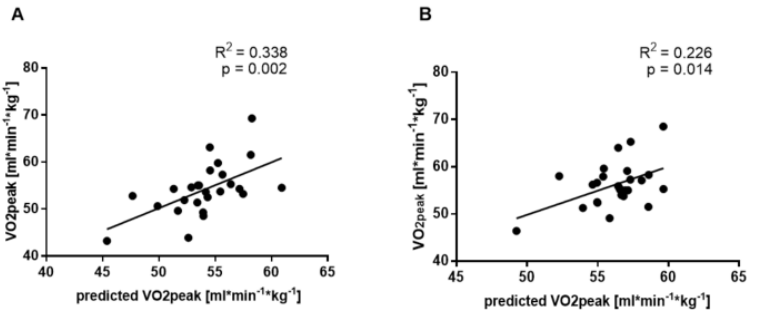
Figure 2. The linear relationship between VO 2peak and predicted VO 2peak before ( A ) and after ( B ) twelve weeks of combined endurance training and supplementation (OMEGA and MCT groups; n = 26).